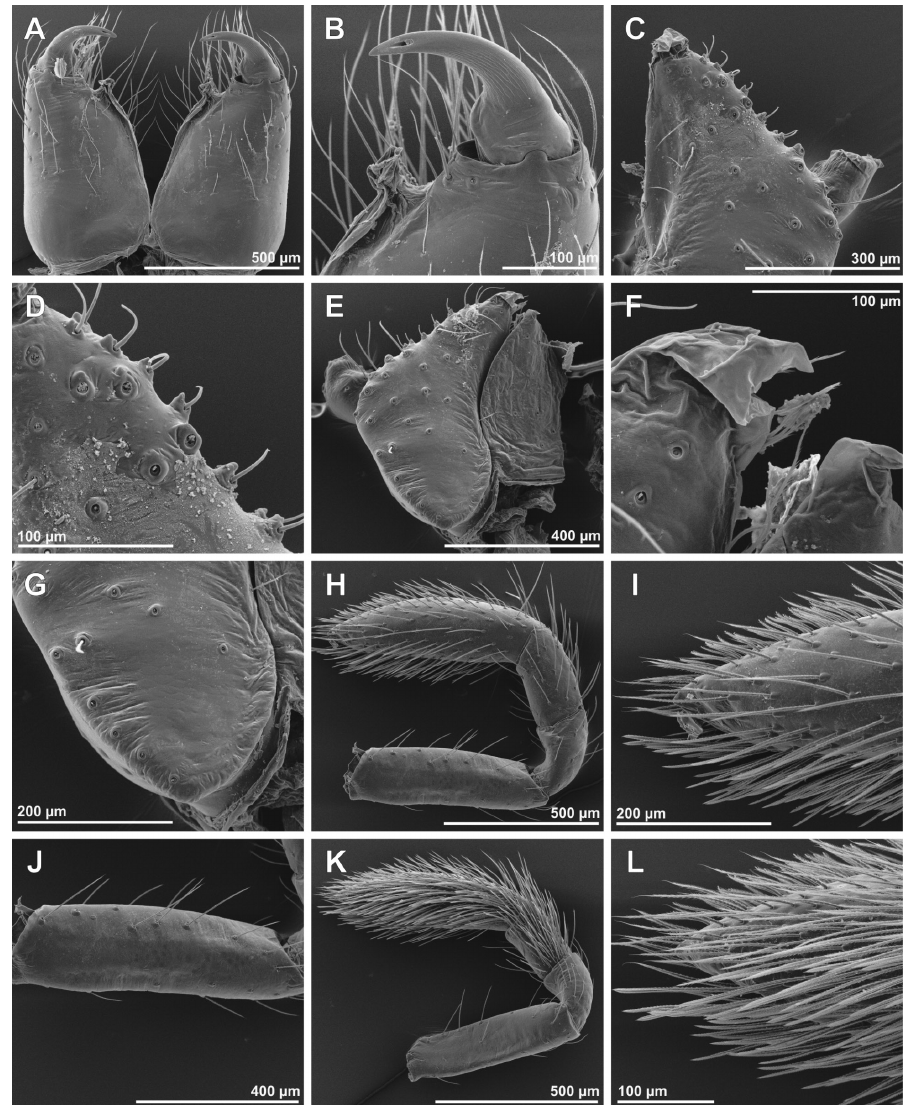
Figure 2. SEM images of Tisentnops mineiro sp. n., female (IBSP 191297) ( A – L ). A – B chelicerae, ven- tral view C left endite, ventral view D detail on left endite, ventral view E right endite and labium, ventral view F detail apical on right endite, ventral view G base of right endite, ventral view H left pedipalp, retrolateral view I tip detail of left pedipalp, retrolateral view J femur of left pedipalp, retrolateral view K right pedipalp, prolateral view L tip detail of right pedipalp, prolateral view. 17/V/2013 (IBSP 191325-191326); Cave AVG-66 (19°49'28"S, 43°41'34"W), 1 ♂ , 08/IV/2014 (IBSP 191305), all collected by M. P.A. Oliveira; Itabirito, Gruta MP-10 (20°15'58"S, 43°53'16"W), 1 imm., 30/III/2012, Equipe Carste col. (IBSP